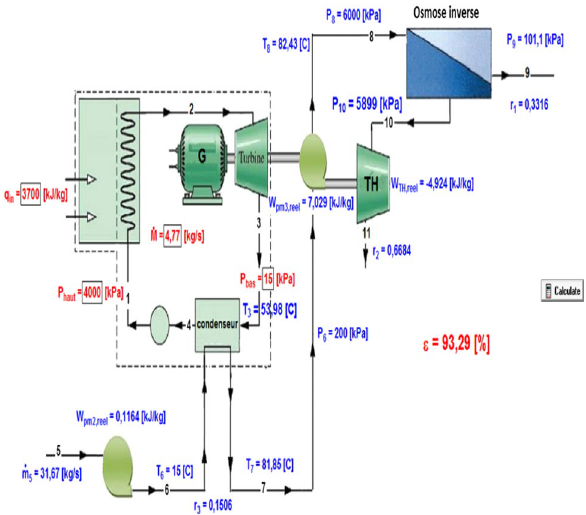
Fig. 11 Block diagram of power and water cogeneration by RO with hydraulic turbine with thermal coupling